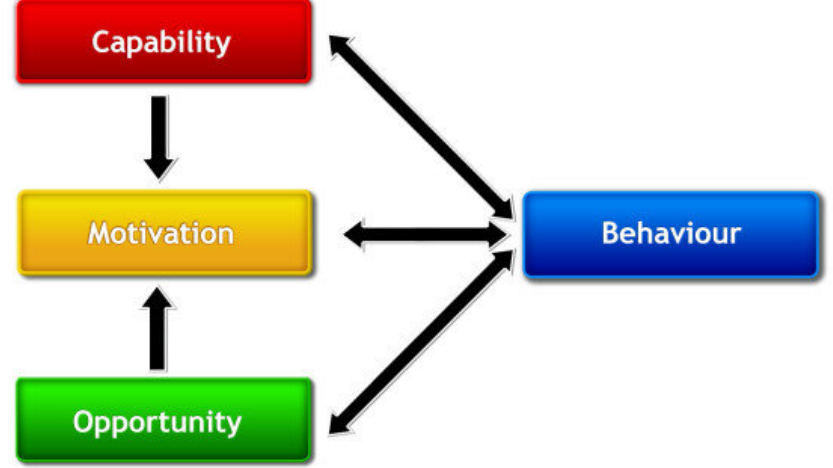
Figure 1. Capability, opportunity, motivation, and behavior